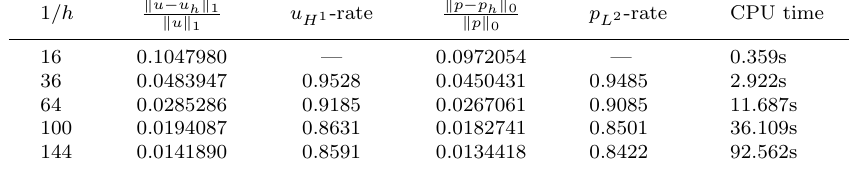
Table 6. Relative error and convergence rate of the one-grid method for the velocity and flux with τ 2 = h and ν = 0 . 01. 1 /h